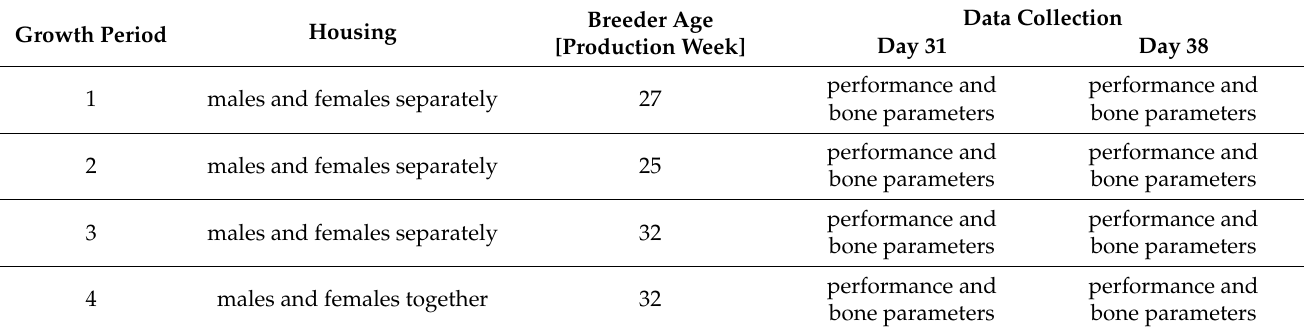
Table 1. Overview of the experimental design and the data collection.